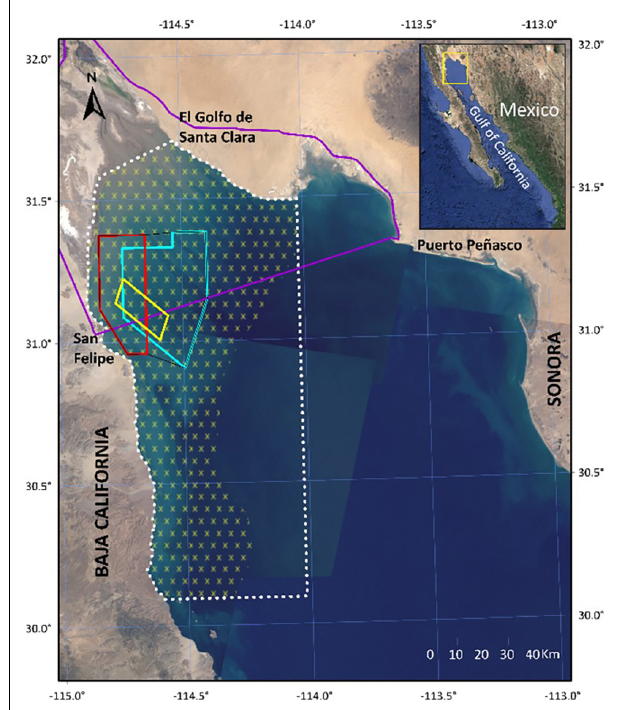
FIGURE 1 | Historical distribution of vaquitas (yellow hatched area) in the upper Gulf of California. The Upper Gulf of California and Delta of the Colorado River Biosphere Reserve (outlined in purple), designated by UNESCO in 1995, because of the unique habitat and presence of endangered species. The Vaquita Refuge (agreed to in 2005 and enacted in 2008 as a no fishing zone) is outlined in aqua blue. The gillnet exclusion zone (where fishing with gillnets is banned but other types of fishing are allowed) was given straight boundaries (dotted white) described by single latitude and longitude to facilitate enforcement and enacted in 2015 (Comité Internacional para la Recuperación de la Vaquita [CIRVA], 2014). Due to the drastic decline in vaquita numbers due to the resurgence of the illegal totoaba fishery, an enhanced enforcement zone (red) was recommended by Comité Internacional para la Recuperación de la Vaquita [CIRVA] (2017) in the area where the remaining vaquitas are thought to spend most of their time and that has high levels of illegal totoaba fishing effort. The Zero Tolerance Area (ZTA) is where CIRVA recommends nets must be removed within hours of being set (outlined in yellow). Despite these designations for vaquita protection, gillnets continue to be used and the population continues to decline toward extinction. Landsat satellite composite imagery provided by U.S. Geological Survey, National Aeronautics and Space Administration (NASA) and Esri, Inc. Projection UTM. Datum WGS84. Figure and caption adapted from Comité Internacional para la Recuperación de la Vaquita [CIRVA] (2019) and Jaramillo-Legorreta et al.